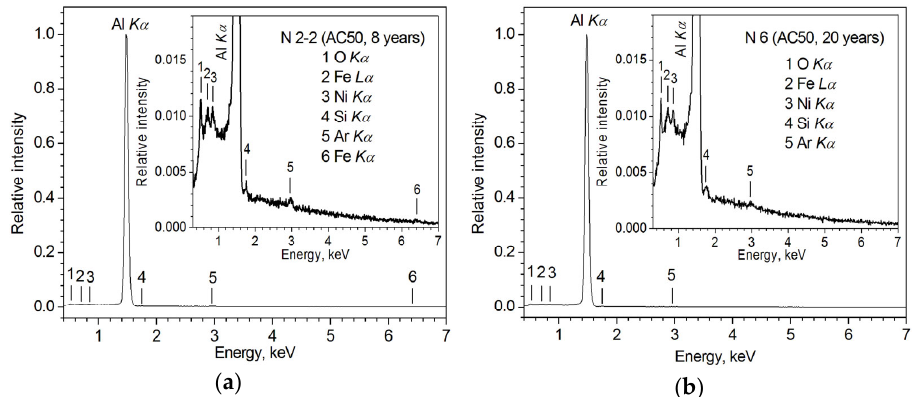
Figure 1. EDX spectra of the AC50 samples ( a ) N2 ‐ 2 (8 years of service life), ( b ) N6 (20 years of service life).